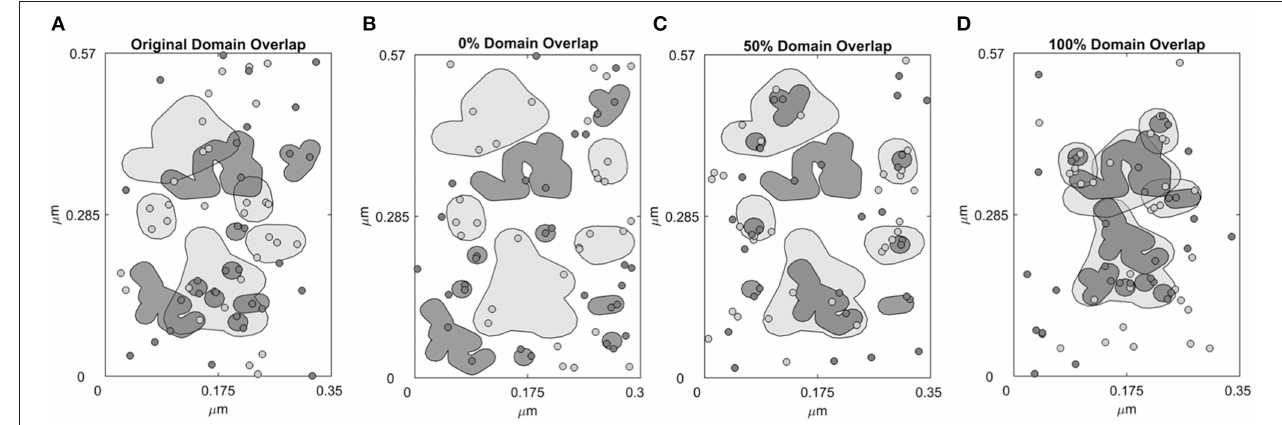
FIGURE 1 | Four domain configurations of the simulation space. Simulation space was partitioned into receptor-specific domains with defined domain overlaps. (A) A simulation space that mimics the domain properties of CHO cells overexpressing ErbB2 and ErbB3 based on domain analysis of SPT data. ErbB2 (light gray, shaded) and ErbB3 (dark gray, shaded) membrane domains overlap by 42.4%. ErbB2 receptors (light gray, circled) and ErbB3 receptors (dark gray, circled) are randomly distributed within their own domains as well as outside the domains (white region). (B–D) Domains were rearranged to create a simulation space where the ErbB2 and ErbB3 domains are completely non-overlapping (0% overlap, B ), partially overlapping (50% overlap, C ) or completely overlapping (100% overlap, D ). In the initial configuration, ErbB2 and ErbB3 receptors were positioned to randomly occupy their respective domains.